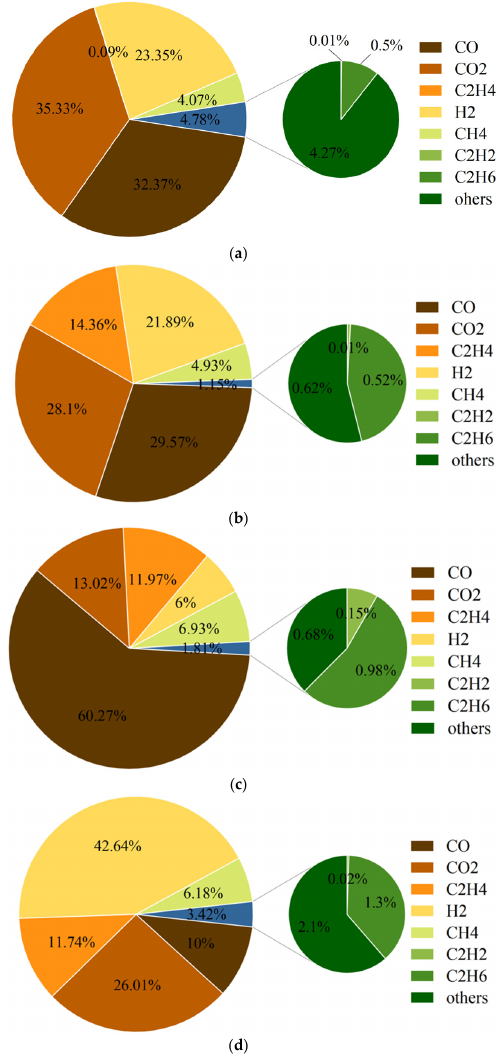
Figure 5. Gas production composition and volume percentage of four samples. ( a ) Sample No.1 (NCM622). ( b ) Sample No.2 (NCM811). ( c ) Sample No. 3 (NCM9/0.5/0.5). ( d ) Sample No. 4